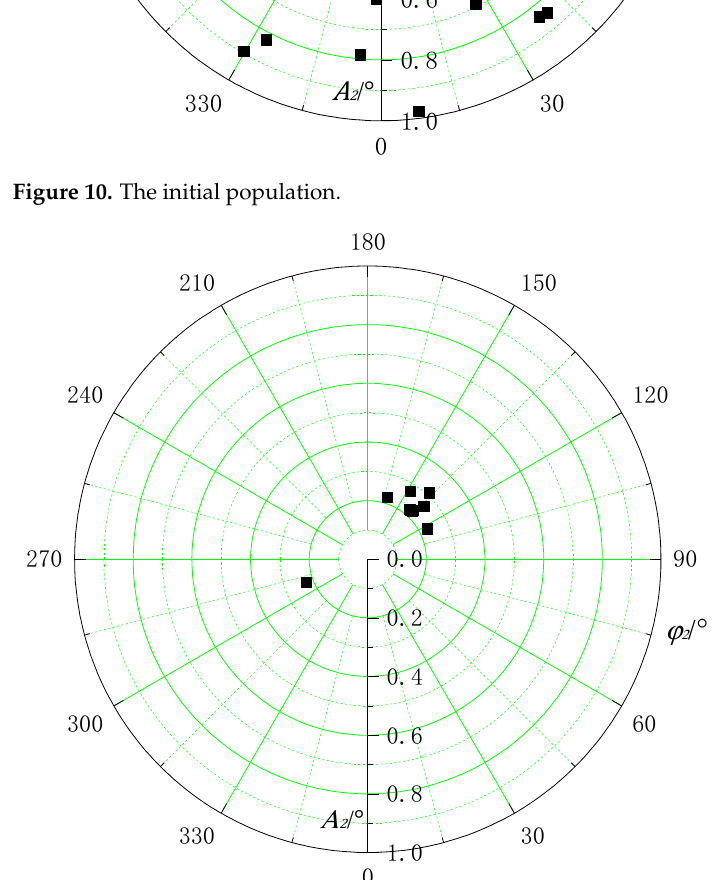
Figure 11. The final population.